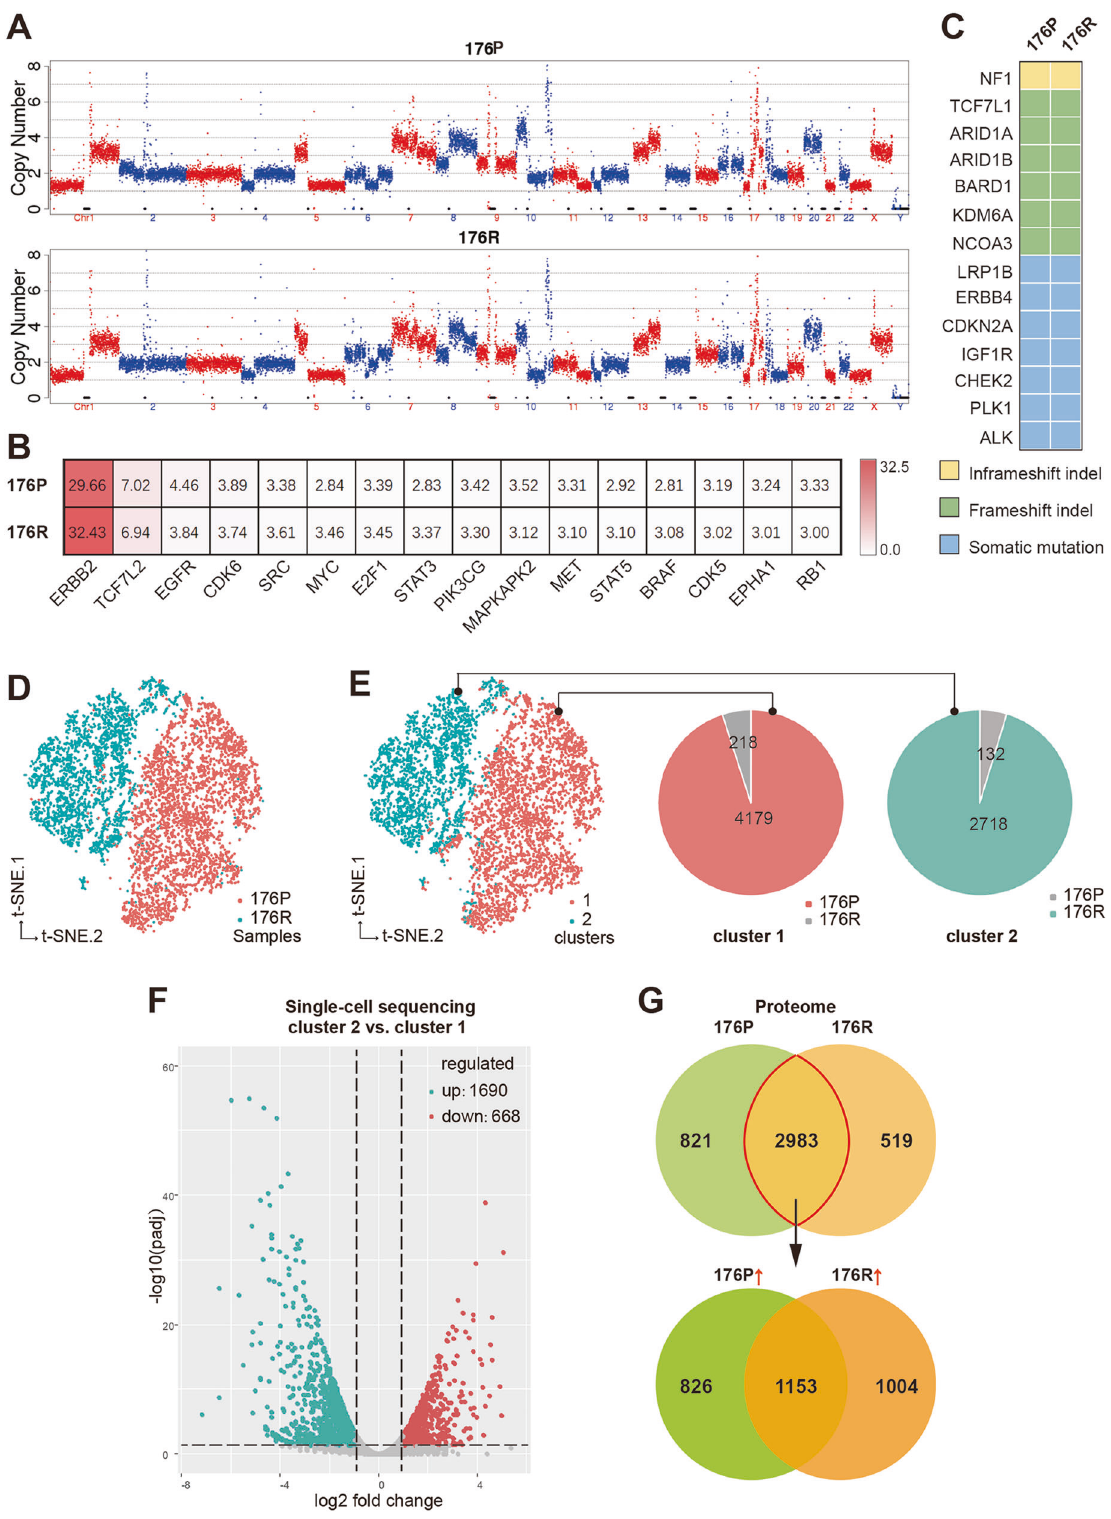
Gene expressional changes, rather than genomic variations, contributed to acquired Trastuzumab resistance Based on the whole-genomic analysis, no signi fi cant changes